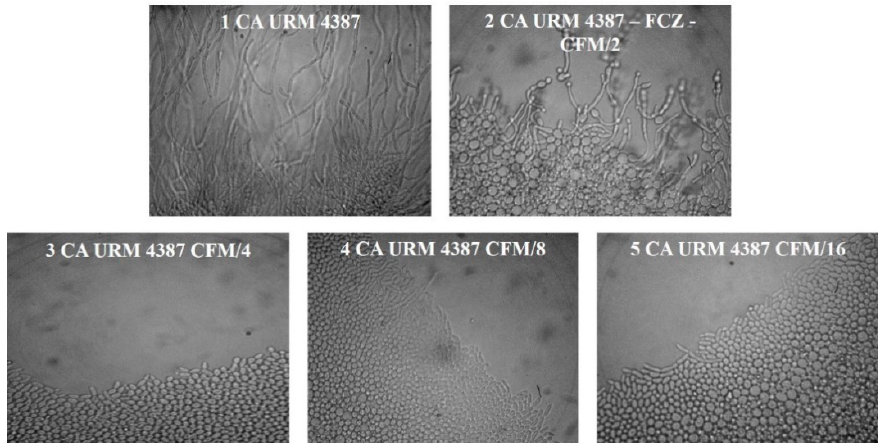
Figure 4. Effects of essential oil of Piper caldense on the dimorphism of Candida albicans URM 4387. Slide (S1): Growth control; S2: Effect of fluconazole at the concentration of 8 μ g/mL. S3–5: Effect of the essential oil at 2048 μ g/mL (S3), 1024 μ g/mL (S4), 512 μ g/mL (S5).